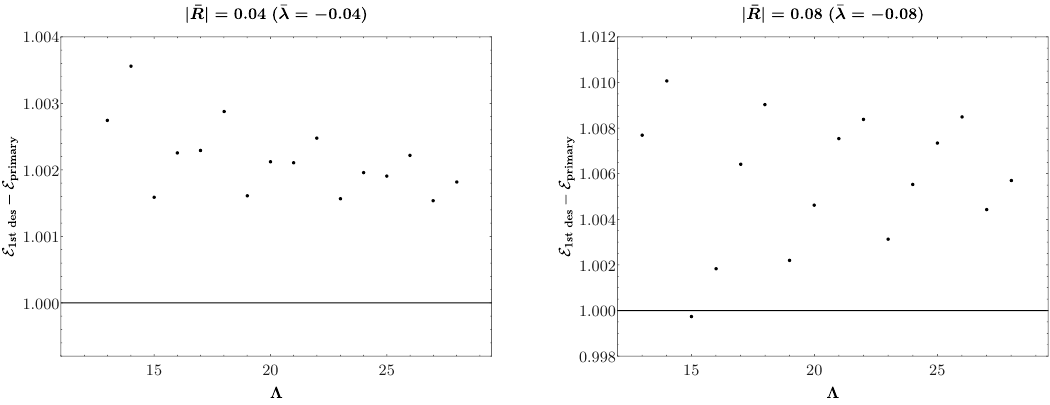
Figure 26. Gap between the first excited state and its leading descendant, in the Ising model with thermal deformation, for ¯ λ < 0 . When the coupling is sufficiently negative, the restoration of conformal invariance is extremely slow, if at all